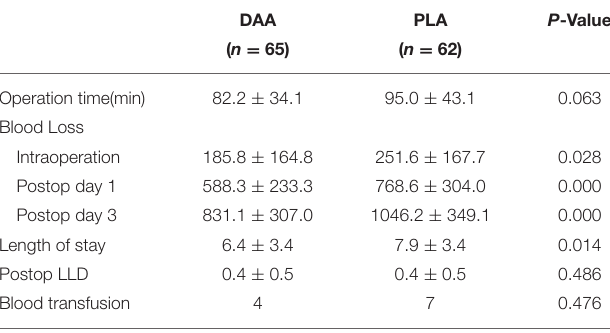
TABLE 5 | Surgical characteristics and perioperative